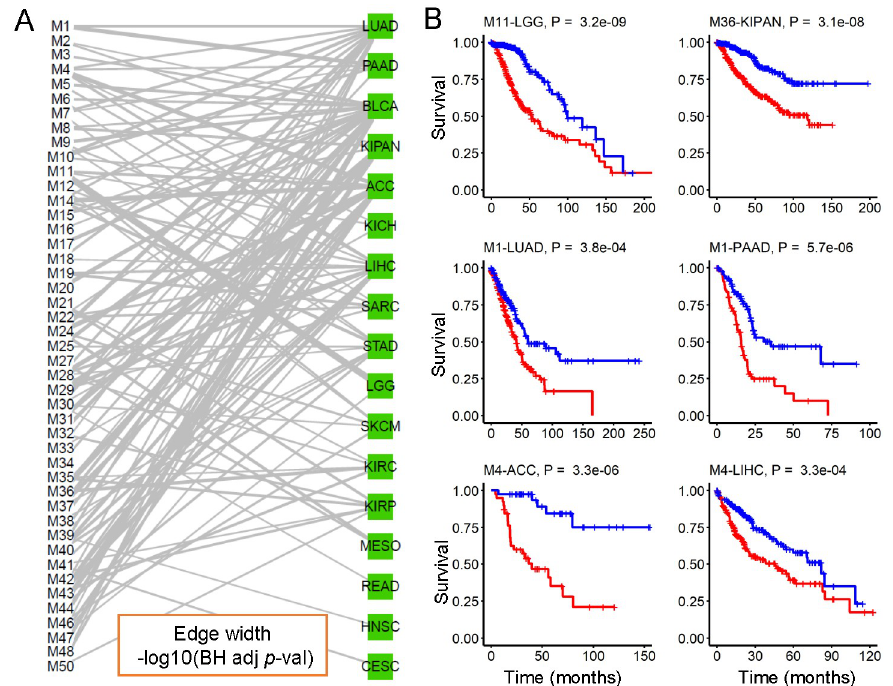
Fig 7. Survival analysis of modules. (A) showing a bipartite graph between the identified modules and the different cancer types based on these -log 10 (BH adjusted P -value). For each identified module and each cancer within the module, we first extracted the first principal component (PC1) based on the expressed matrix of both miRNAs and genes within the module from the cancer type. We then divided the samples from the cancer type into two groups based on the median value of PC1 and a P -value was compute using log-rank test. In the graph, we only kept these edges/relationships between the modules and cancer types with adjusted P < 0.05. (B) Some cancer-miRNA-gene modules relate to survival time. For a given cancer type and a given module, the Kaplan-Meier survival curves were drawn for each group, and “+” denotes the censoring patient. Each sub-figure corresponds to a module and a cancer type. For example, Module 11 has a significant P = 3.2e-09 for LGG (cancer type), written as “M11-LGG, P =